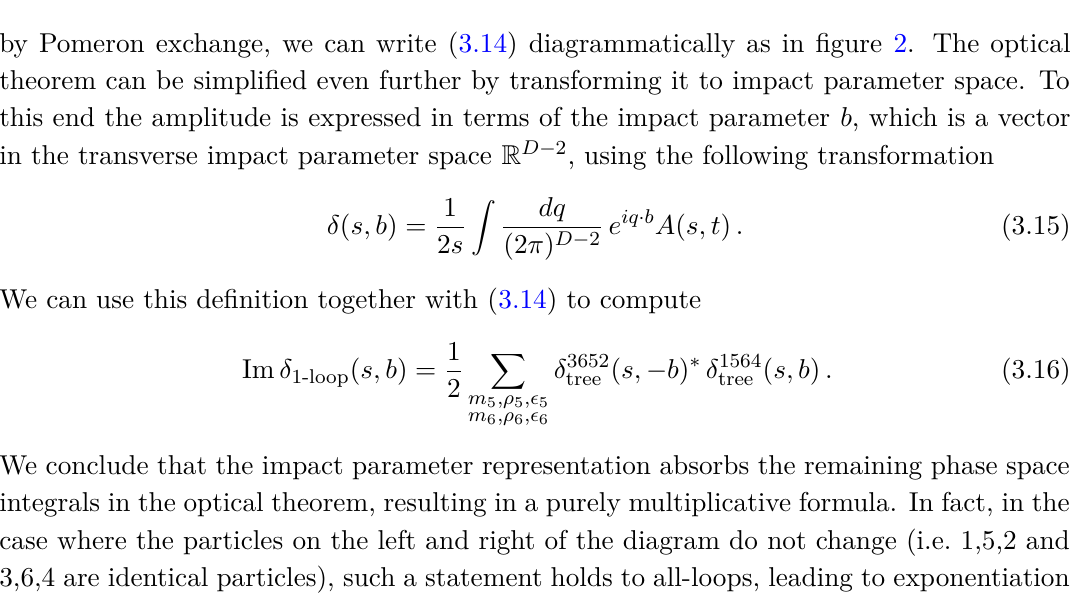
Figure 2 . Optical theorem in the Regge limit in terms of Feynman diagrams. The tree-level correlators are dominated by s -channel Pomeron exchange. The ellipses on the l.h.s. indicate that all string excitations are taken into